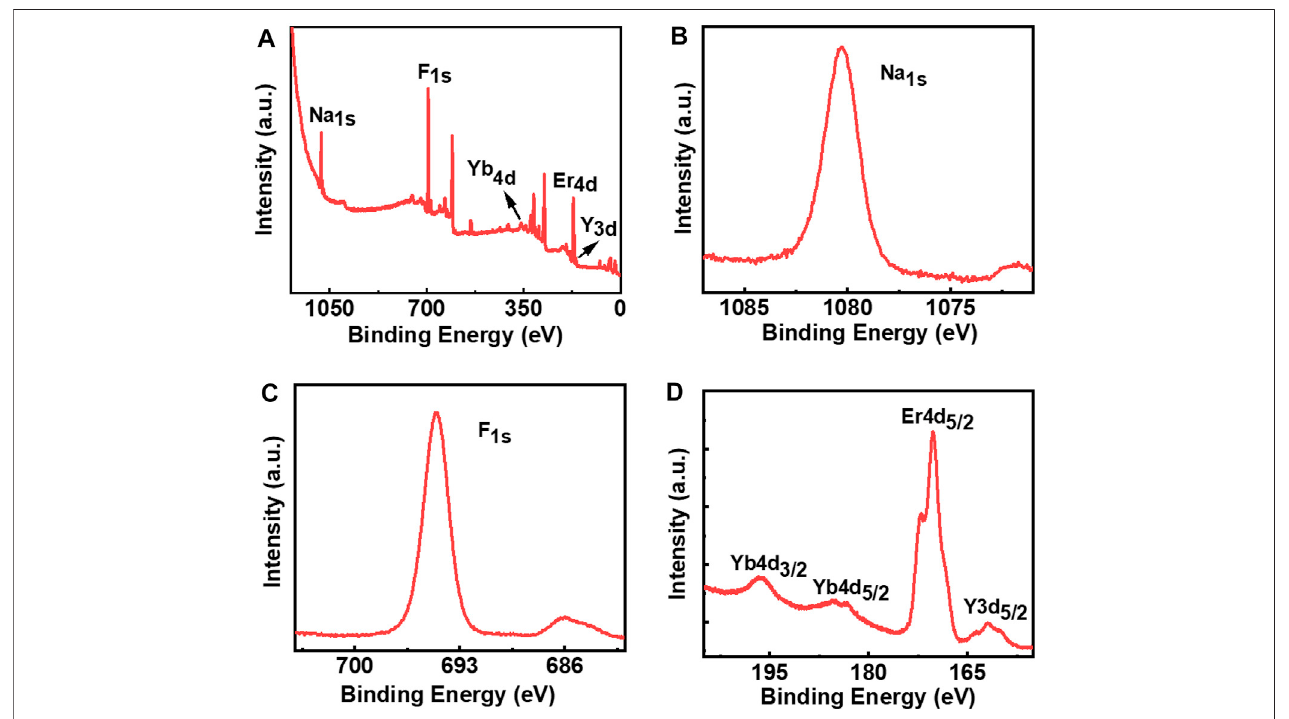
FIGURE 6 | XPS spectra of ligand free NaYF 4 :Yb/Er UCNPs: (A) survey spectrum; (B) Na 1s; (C) F 1s; (D) Yb 4d, Er 4d, and Y 3d.